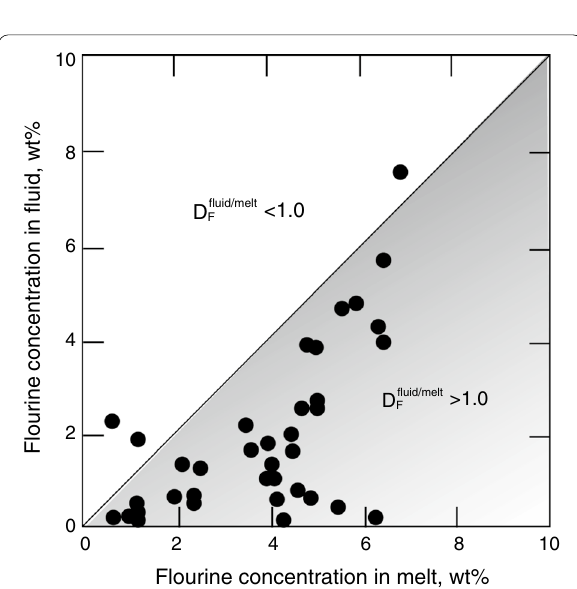
Fig. 7 Fluorine concentration in coexisting aqueous fluid and H 2 O-rich melt for various granitic melt compositions. Modified after Dolejs and Zajacs (2018)